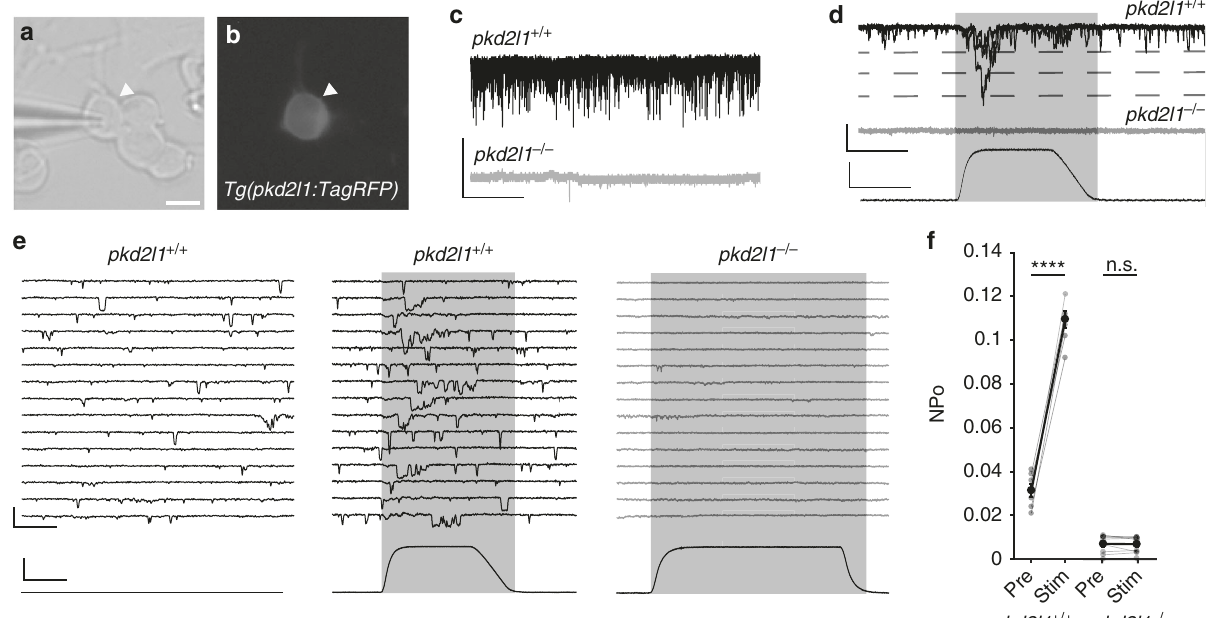
Fig. 4 CSF-contacting neurons require Pkd2l1 to respond to mechanical pressure. a Transmitted light and b fl uorescent images of a cultured CSF-cN from a Tg(pkd2l1:TagRFP) embryo. Scale: 5 µ m. c Gap-free VC recordings from CSF-cNs in vitro show extensive single channel opening in pkd2l1 + / + but not pkd2l1 − / − embryos, comparable to results in vivo. Scale: 2 s, 20 pA. d Gap-free VC recording from a cultured CSF-cN while a mechanical stimulus is applied, showing an increase in channel opening during the stimulus in pkd2l1 + / + . Scale: top: 20 ms, 25 pA, bottom: 20 ms, 2 µ m. e Gap-free recording from cultured CSF-cNs while a mechanical stimulus is applied. Scale: top: 20 ms, 25 pA, bottom: 20 ms, 2 µ m. f Quanti fi cation of channel opening probability in response to mechanical stimulation of pkd2l1 + / + and pkd2l1 − / − CSF-cNs ( n = 7 pkd2l1 + / + CSF-cNs, pre vs. stim p = 1.6 × 10 – 6 ; n = 10 pkd2l1 − / − CSF-cNs, pre vs. stim p = 0.76, paired t test). Error bars represent